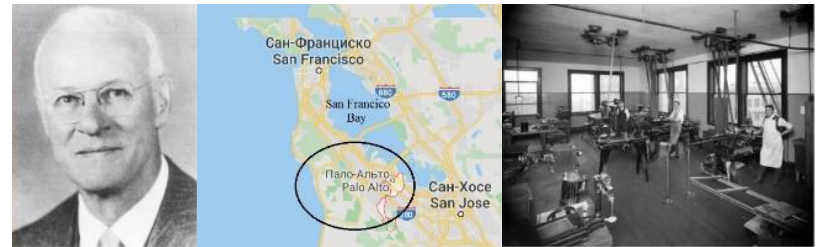
Fig. 7. Cyril Elwell (1947), a map of the San Francisco Bay Area and the workshop of the Federal Telegraph Company in Palo Alto. The dark round object in the lower left corner is a small federal arc transmitter (Photo from the collection of Perham, the history of San